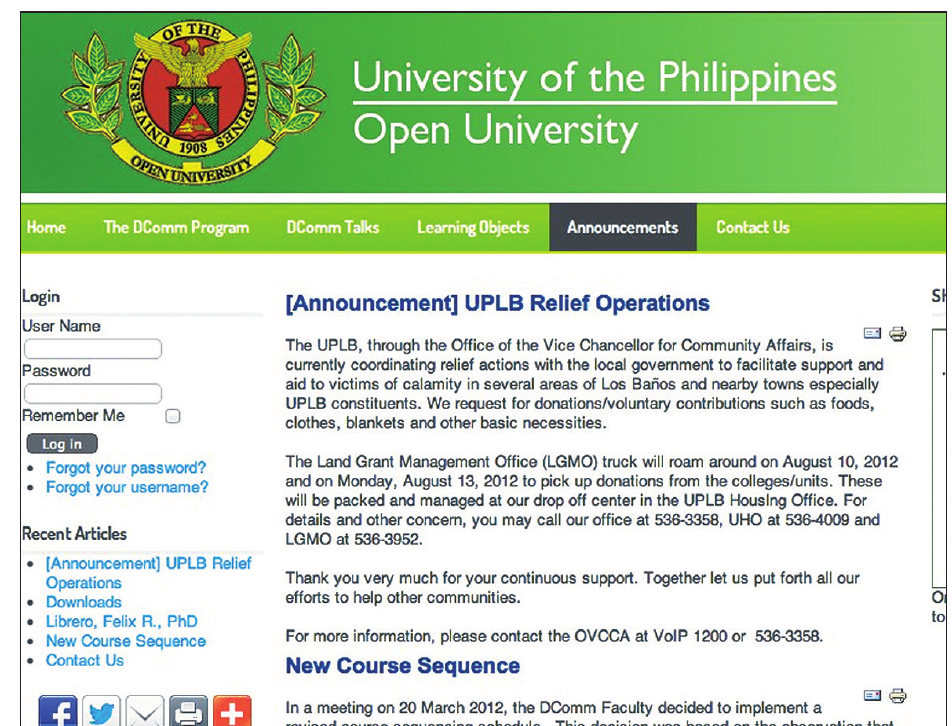
Figure 5 Sample output of emailed